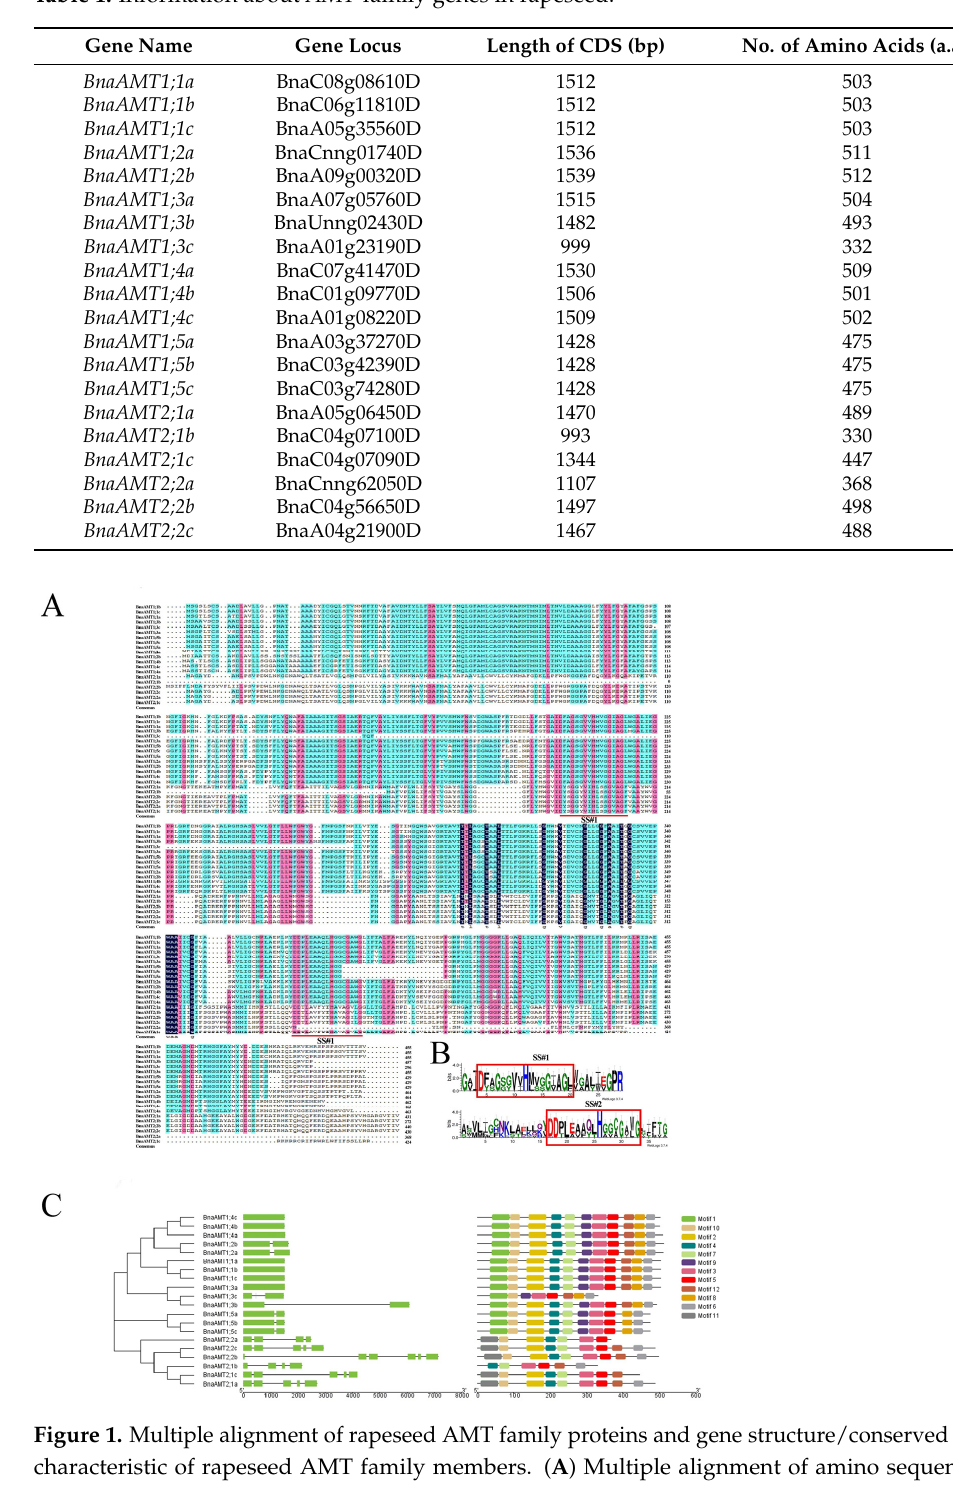
Table 1. Information about AMT family genes in rapeseed.